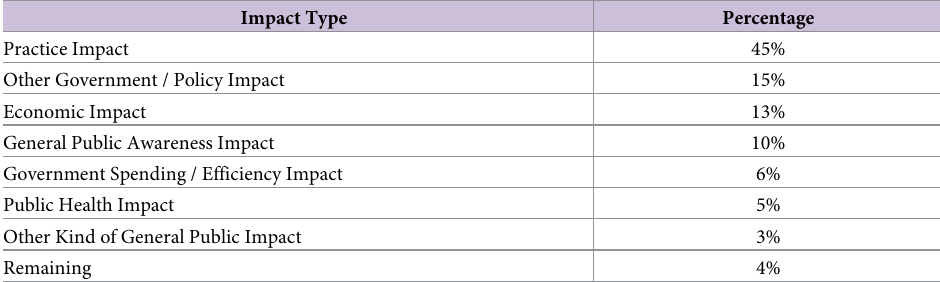
Table 4. Prevalence of different types of impact associated with research